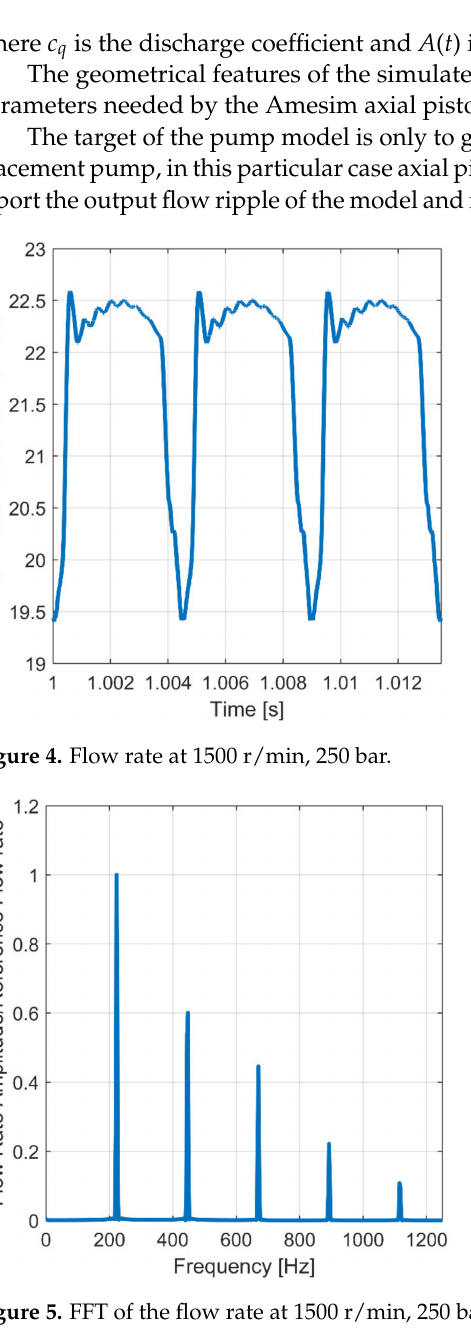
Figure 5. FFT of the flow rate at 1500 r/min, 250